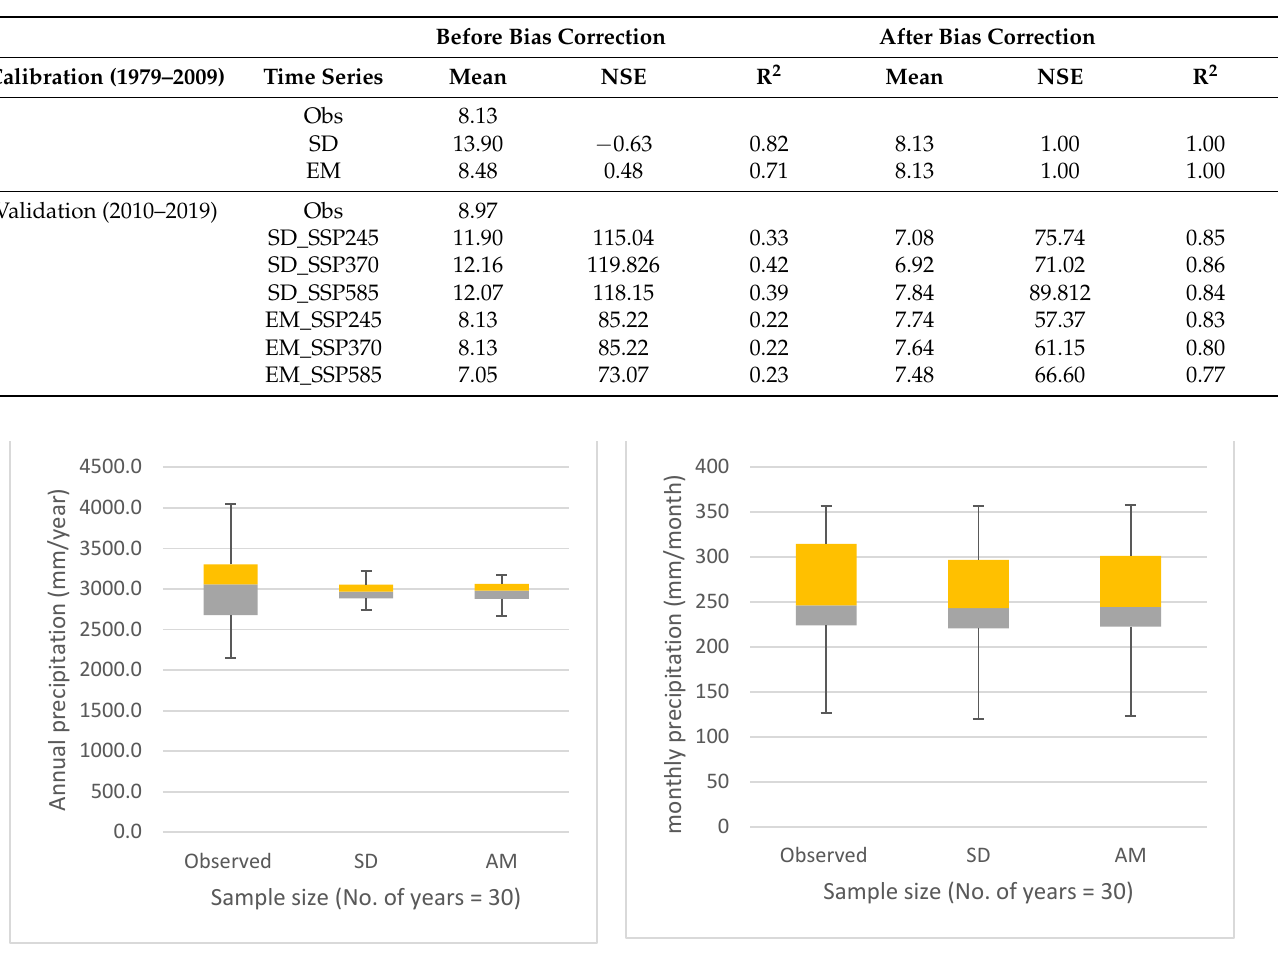
Figure 3. Box plot of annual and monthly simulated precipitation by SD and AM model, N = 30 years. Table 4. Summary of mean and standard deviation for calibration and validation period before and after bias correction for SD model and AM model.